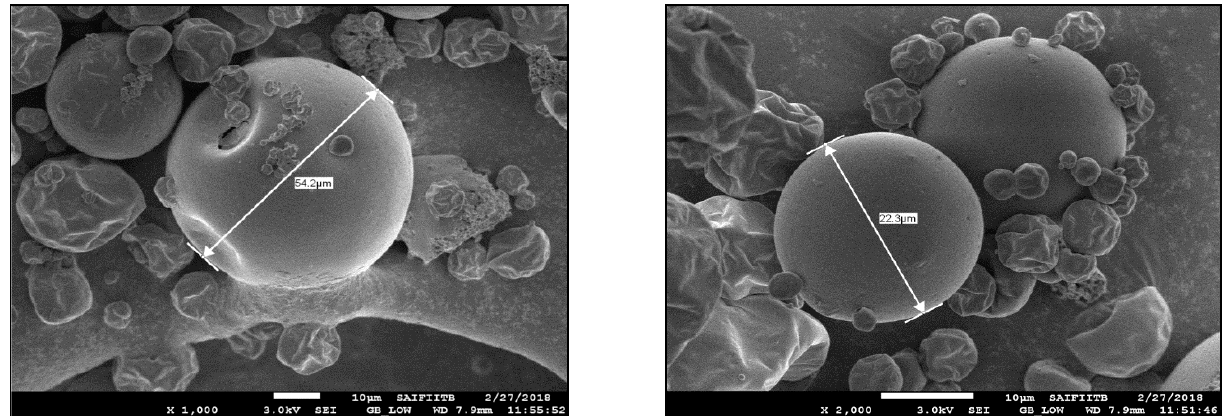
Figure 1. Scanning electron microscopic images on encapsulated Dhavana Oil. Particle size of the encapsulated oil was also studied [11,13,15] and presented in Table 4. Average particle size (psd) was found to be ~ 60 µm, and d(0.90) value < 59.36 µm as calculated from the dynamic light scattering technique (DLS). The particle size distribution is shown in Figure S12. Table 4. Particle size analysis of encapsulated Dhavana oil. Sr.